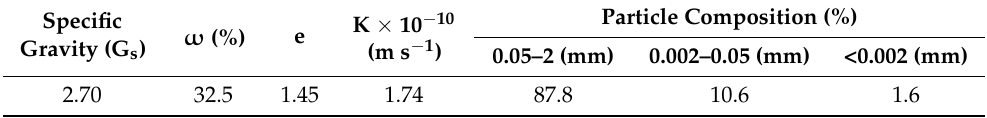
Table 1. The physical properties of silty sand.